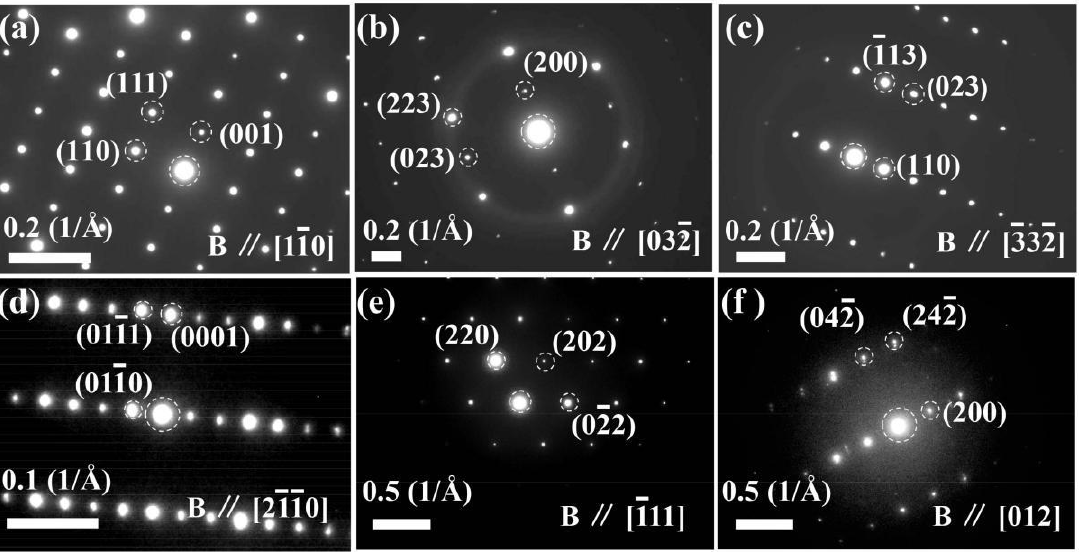
Figure 8. The SAED patterns of ( a – c ) Y phase in as-cast alloy #3, ( d ) µ 7 phase and ( e , f ) Mg 3 Sm in alloy #3 annealed at 320 °C for 56 days.